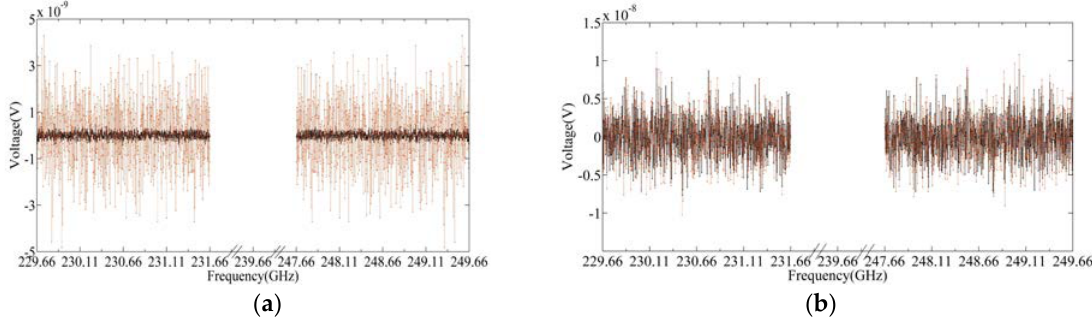
Figure 5. Thermal noise signal spectrum for the hot target and cold target in 240 GHz S5 upper and lower sidebands: ( a ) Tsys = 0 K; ( b ) Tsys = 1000 K.